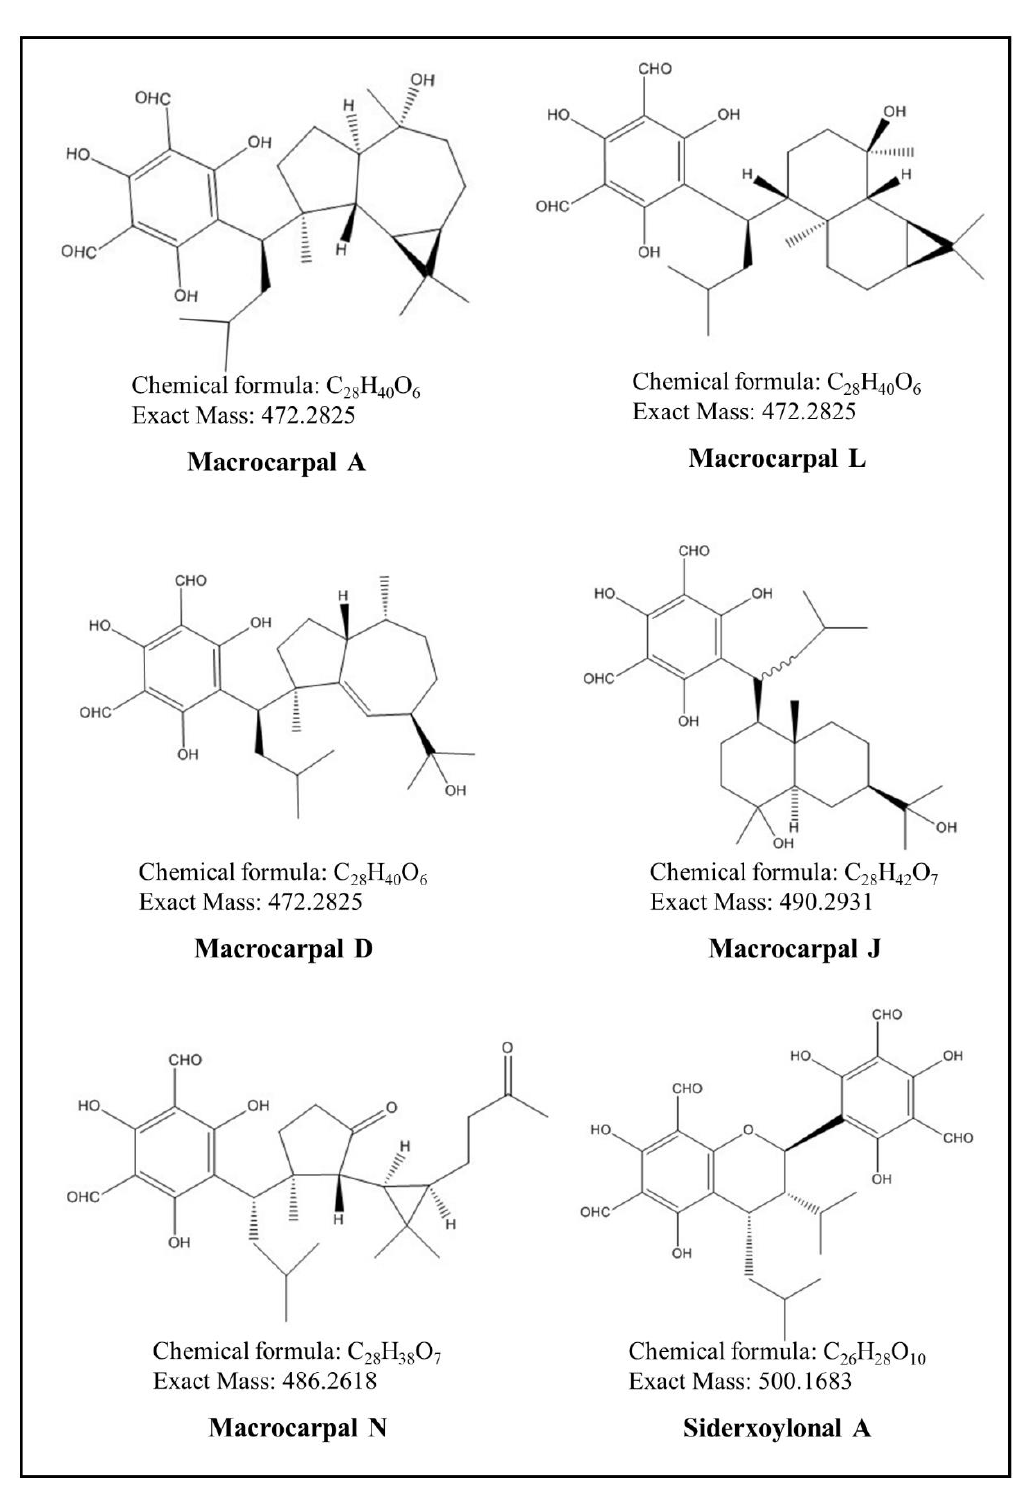
Figure 1. Structural formulas of six different FPCs identified in E. globulus leaves. 142